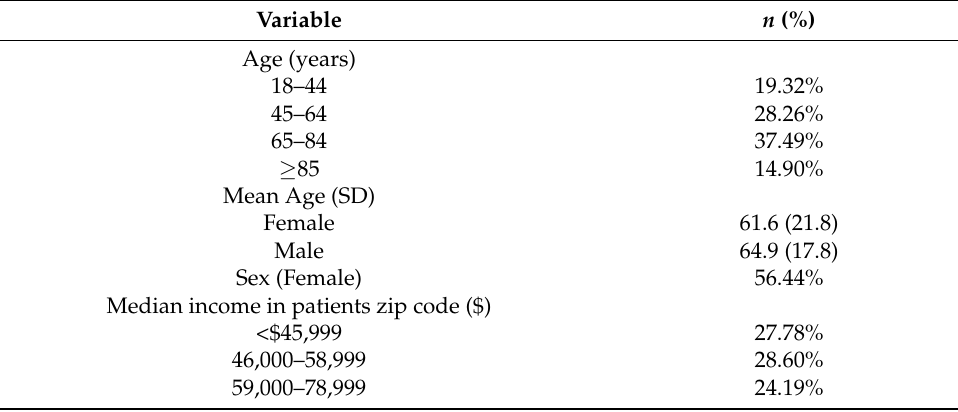
Figure 1. Cholecystectomy inclusion criteria. Table 1. Patient characteristics ( n =